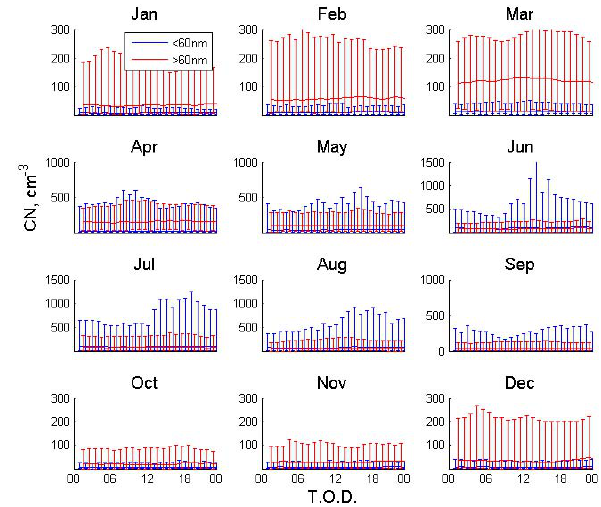
Fig. 10. Monthly (month 1–12) diurnal variation of median num- ber concentration D p < 60nm and D p > 60nm. 5–95th percentile ranges are indicated by errorbars. March 2000–March 2010. T.O.D. represents “Time of Day”. Note the different scale of y-axis for the different